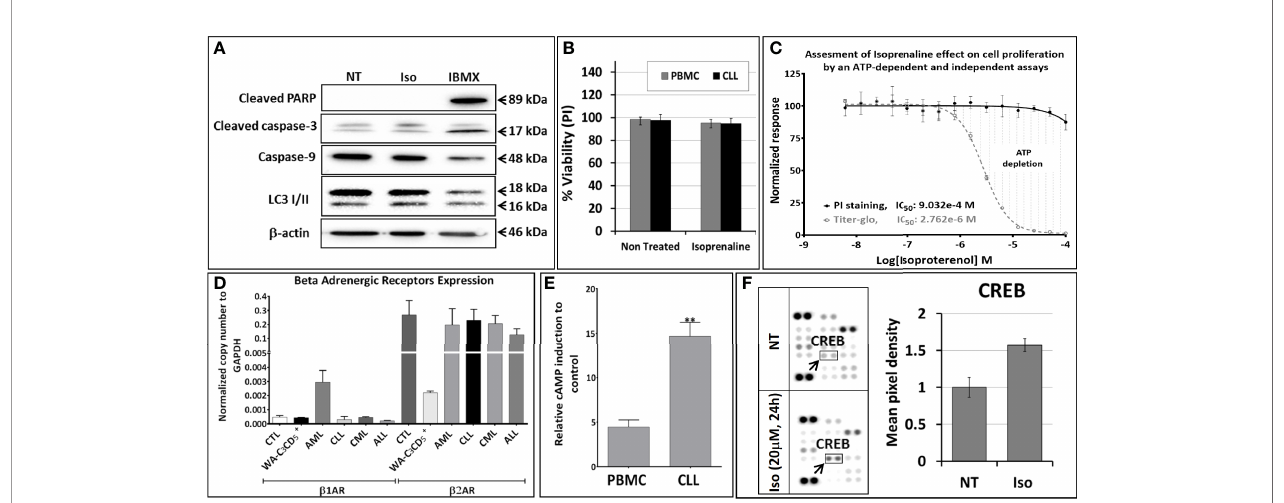
FIGURE 3 | Isoproterenol does not induce cell death in primary CLL cells but it induces a long-lasting dose-dependent intracellular ATP depletion. (A) Primary CLL cells were treated with 3µM Isoprenaline (IC 50 determined using the CellTiter-Glo assay) for 48h. Markers of apoptosis (cleaved PARP, cleaved caspase-3 and caspase- 9) and autophagy (accumulation of LC3 II) were assessed by western blotting. The non-competitive selective phosphodiesterase inhibitor, IBMX, known to induce apoptosis in CLL B cells, was used as a positive control. Full-length blots/gels are presented in Supplementary Figure 5 . (B) Isoprenaline-induced cell death in normal PBMC (black bars) and in primary CLL cells (gray bars) was also assessed by propidium iodide staining followed by fl ow cytometry analysis. (C) Cytotoxic effect induced by a gradient of Isoprenaline concentrations (dose-response plots) was assessed with an ATP-dependent (CellTiter-Glo, dashed line) and independent (PI/ fl ow cytometry) assays. (D) The level of expression of the different adrenergic receptors in primary leukemic cells (ALL, AML, CLL and CML), normal PBMCs and in the CLL cell line WA-C3CD5+ was measured by quantitative real time PCR (qPCR). (E) Isoprenaline-induced intracellular cAMP accumulation in normal PBMCs and primary CLL cells pre-treated for one hour with phosphodiesterase inhibitor (IBMX) than with 10µM Isoprenaline for 24h. (**P < 0.01). (F) Human phosphokinase array reveals alteration in phosphorylation of kinases upon in-vitro treatment of CPCs with 10µM Isoprenaline for 24h. In the array each kinase is spotted in duplicate. Hybridization signals at the corners serve as control. Relative levels of protein phosphorylation (normalized intensity for each antibody) were calculated for each untreated and treated sample. p-CREB (indicated by black arrow) was the only signi fi cantly up-regulated kinase upon Isoprenaline